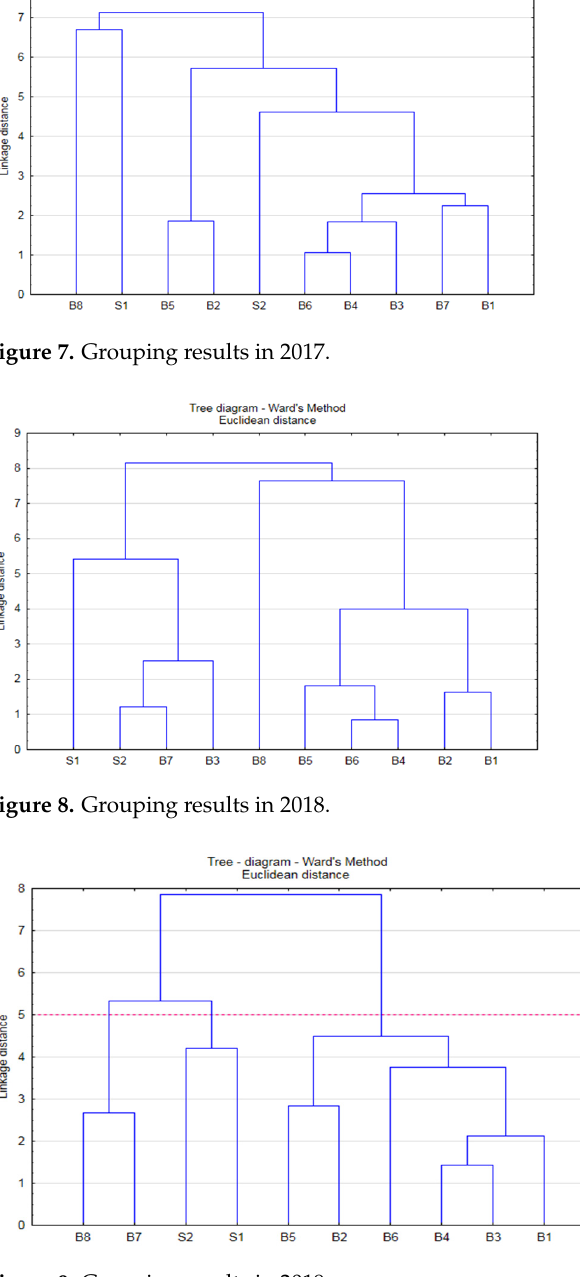
Figure 9. Grouping results in 2019.